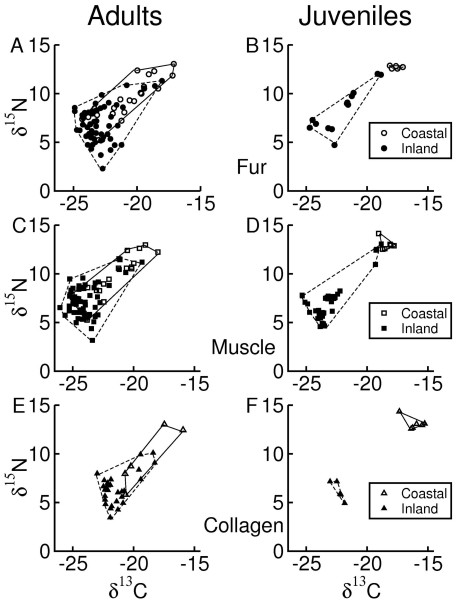
Biplots of δ13C and δ13N values of fur (A, B), muscle (C, D) and collagen (E, F) samples from adult and juvenile arctic foxes from coastal (open symbols) and inland (closed symbols) habitats on Iceland.